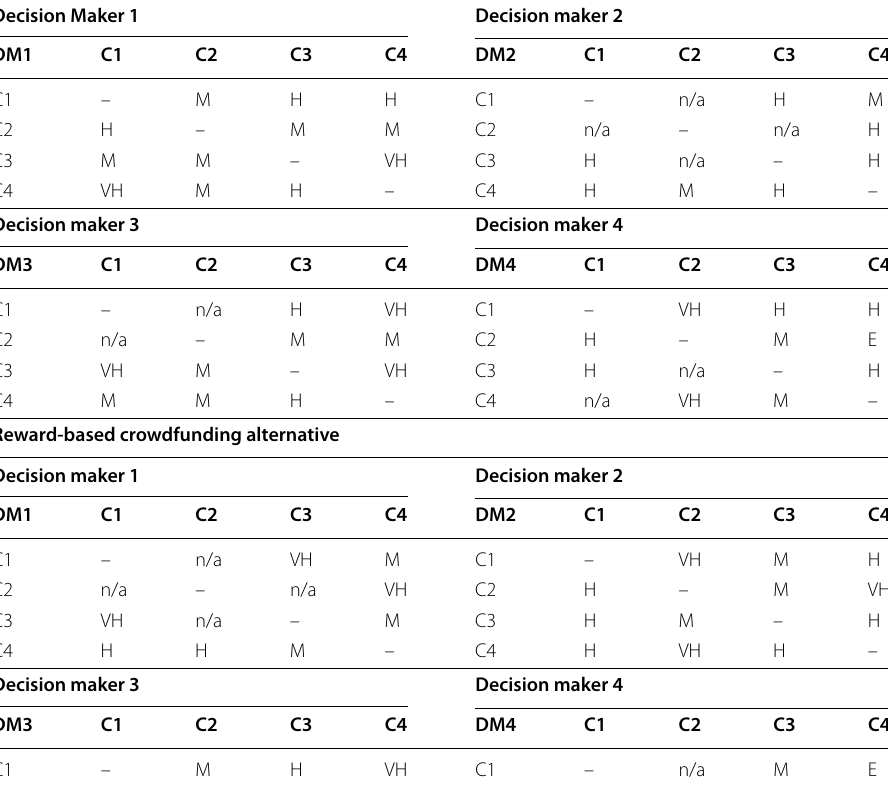
Table 3 Linguistic evaluations for different crowdfunding alternative Equity-based crowdfunding